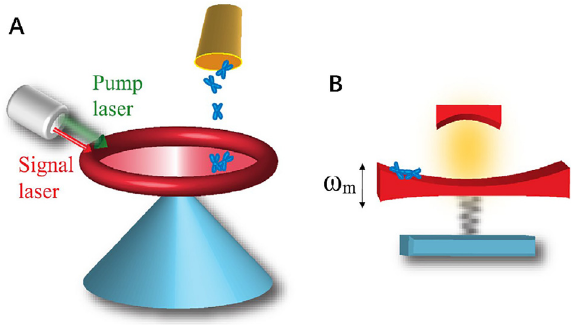
Figure 8: Diagram of the all-optical mass sensor based on an optomechanical system. (A) A strong pump field and a weak signal field are applied to a toroidal nanocavity system, which weighs the masses of biological chromosome. (B) Equivalent figure of (A) in the typical cavity optomechanical system, which consists of a movable mirror connected with a spring and a fixed mirror